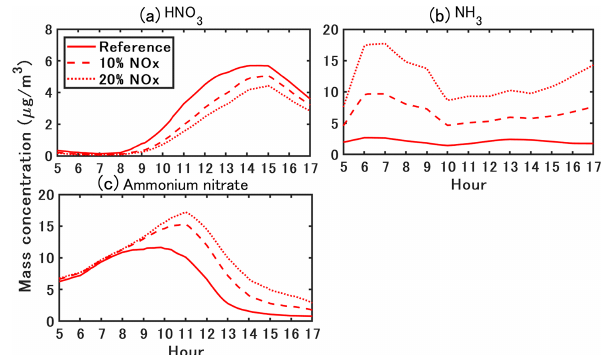
Figure 18. Sensitivity of ammonium nitrate concentration to NH 3